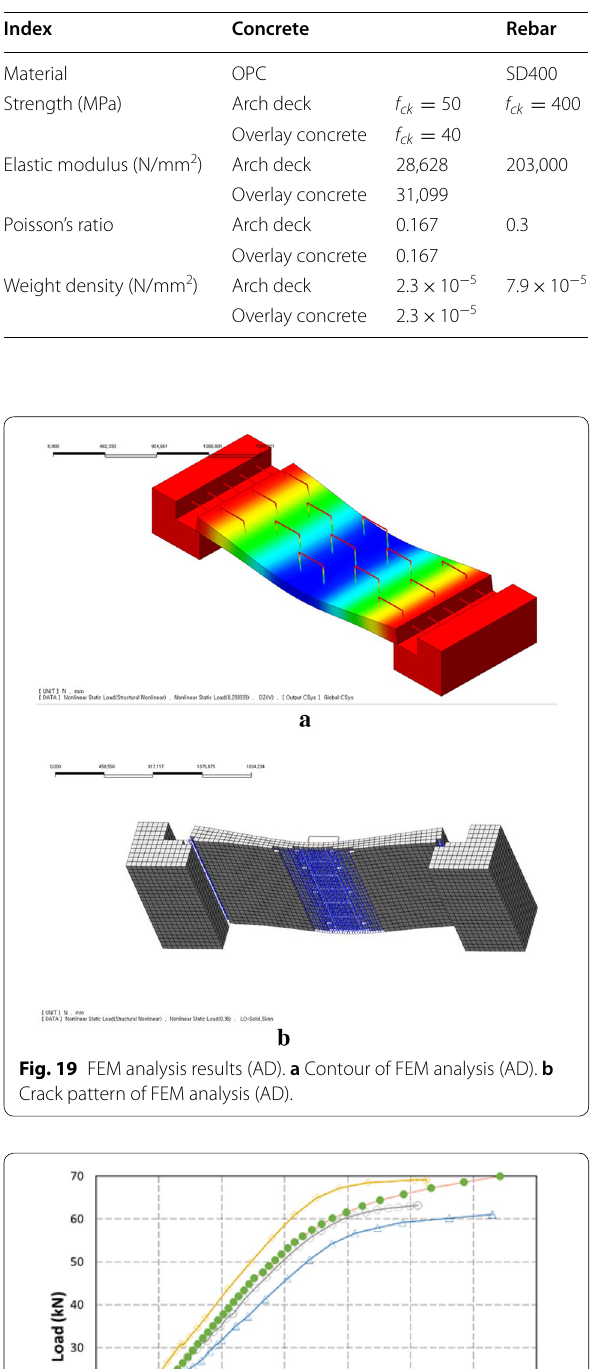
Table 11 Analysis material properties.